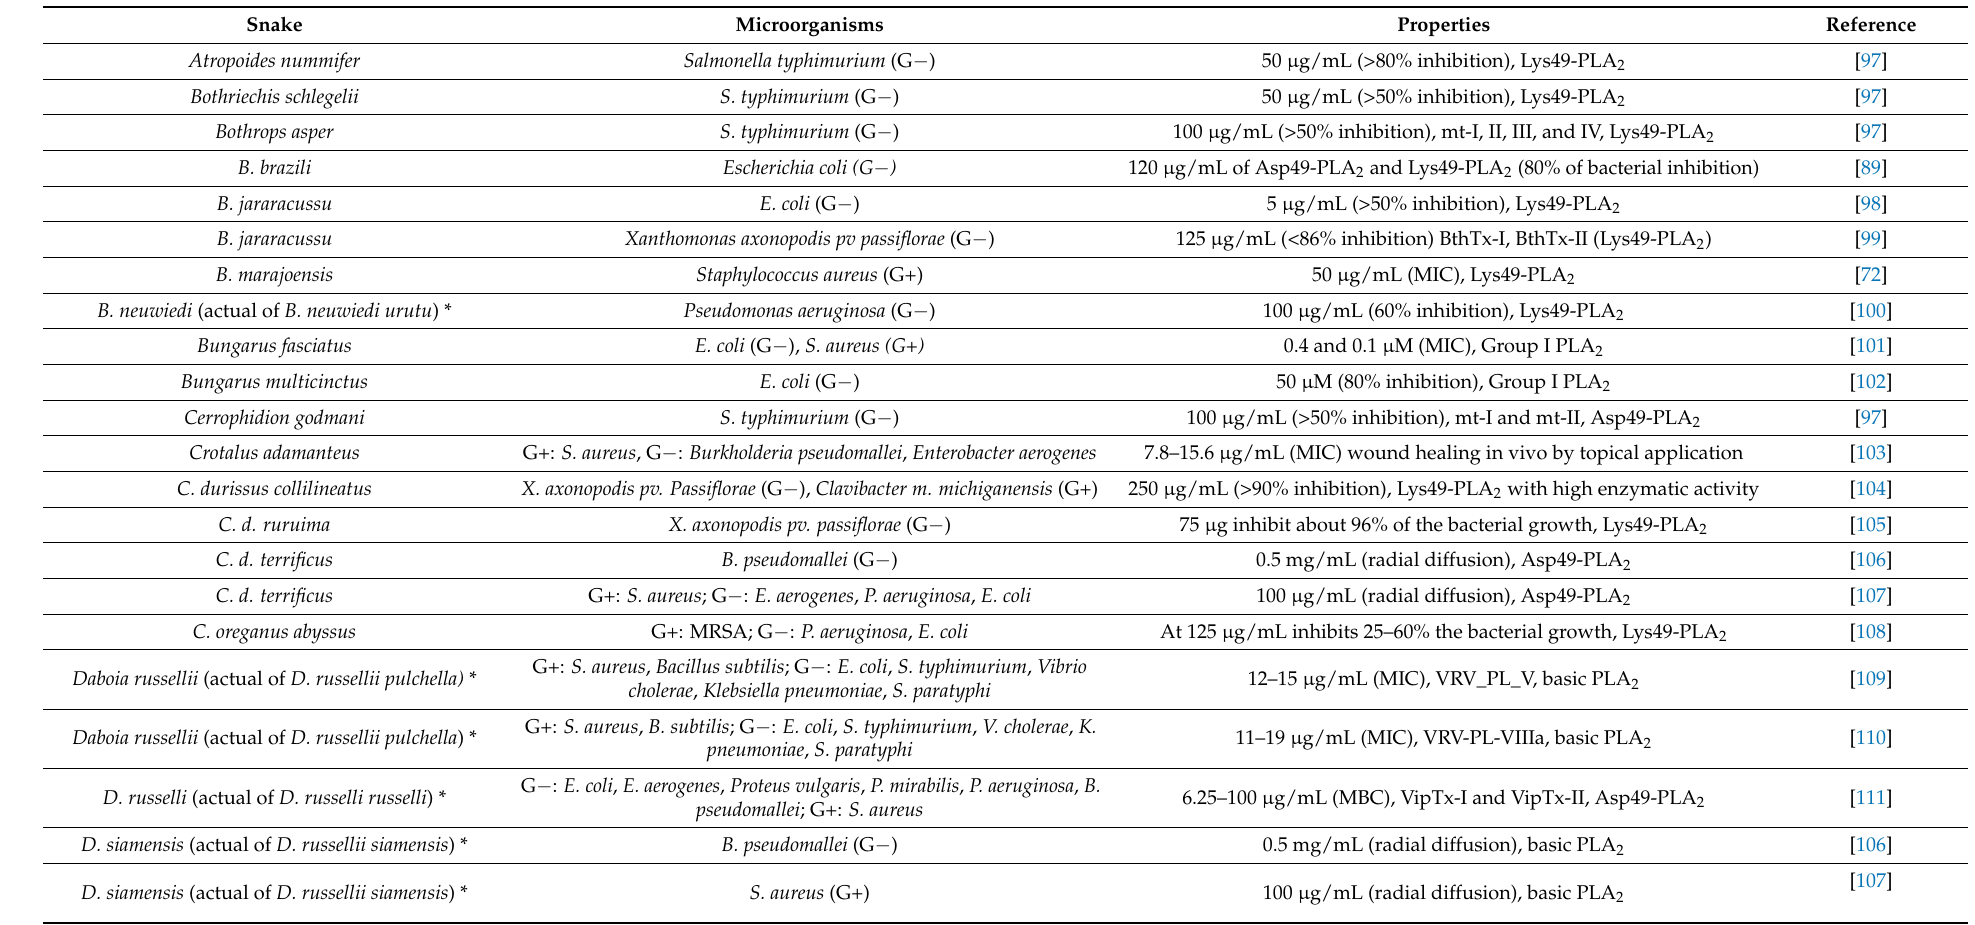
Table 3. Antimicrobial activity of snake-venom phospholipases A 2 (PLA 2